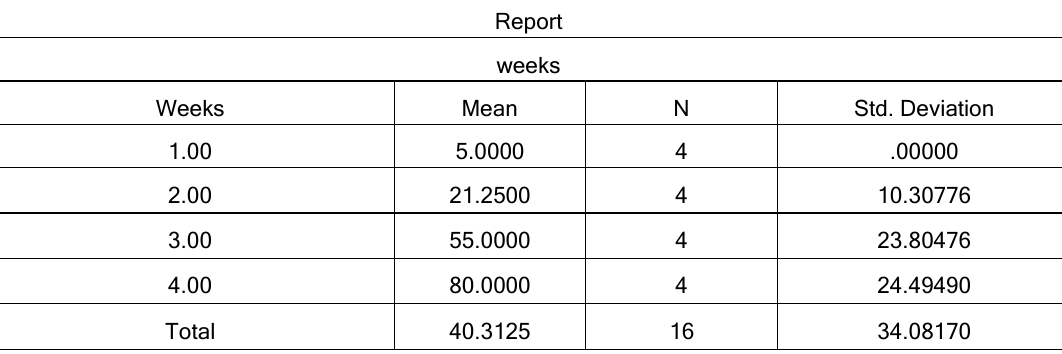
Table(4):show the mean healing period in